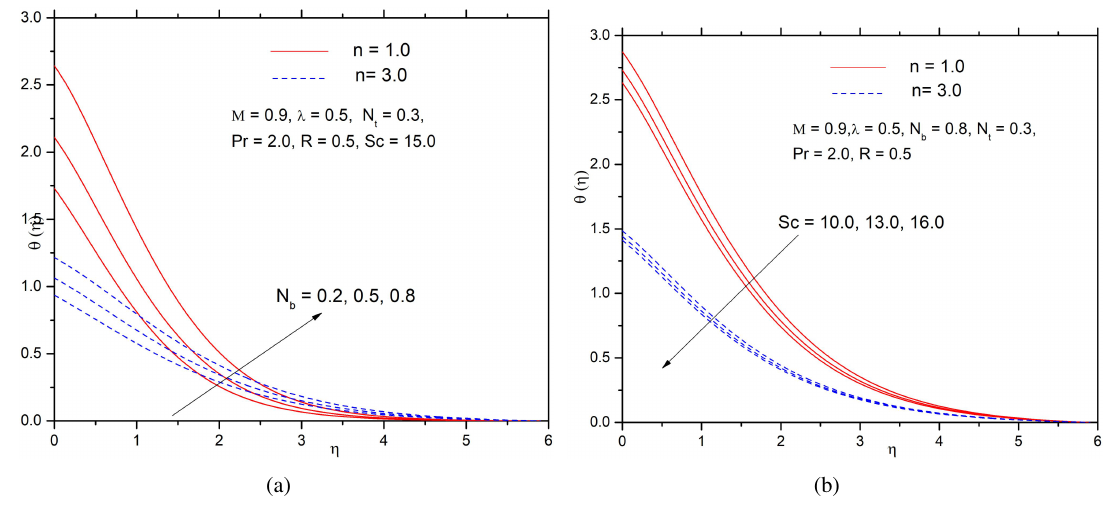
Fig. 8 Effects of (a) N b , the parameter for Brownian motion and (b) Sc, the Schimidt number on temperature θ ( η ) for